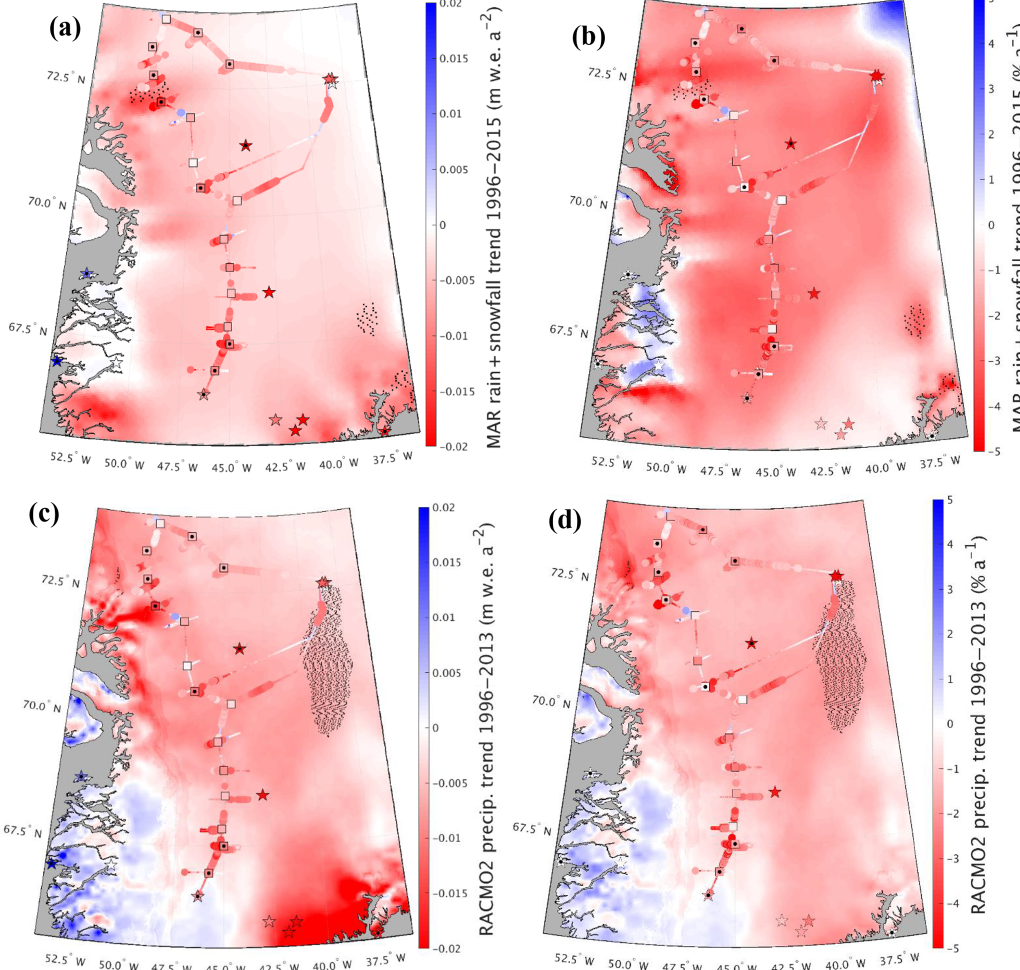
Figure 10. Best-fit linear trends for each grid cell showing magnitude (left) and percent (right) changes in total precipitation for (a, b) MAR (1996–2015) and (c, d) RACMO2 (1996–2013). Statistically significant RCM grid cell trends are stippled black. Also shown are accumulation trends for GreenTrACS firn cores (squares), ACT10A, ACT10B, ACT10C, D4, D5, Katie, Sandy, Summit 2010, and Raven– Dye-2 cores (stars on ice sheet) and precipitation trends from Mernild et al. (2014; stars on coast) with statistically significant trends indicated by black